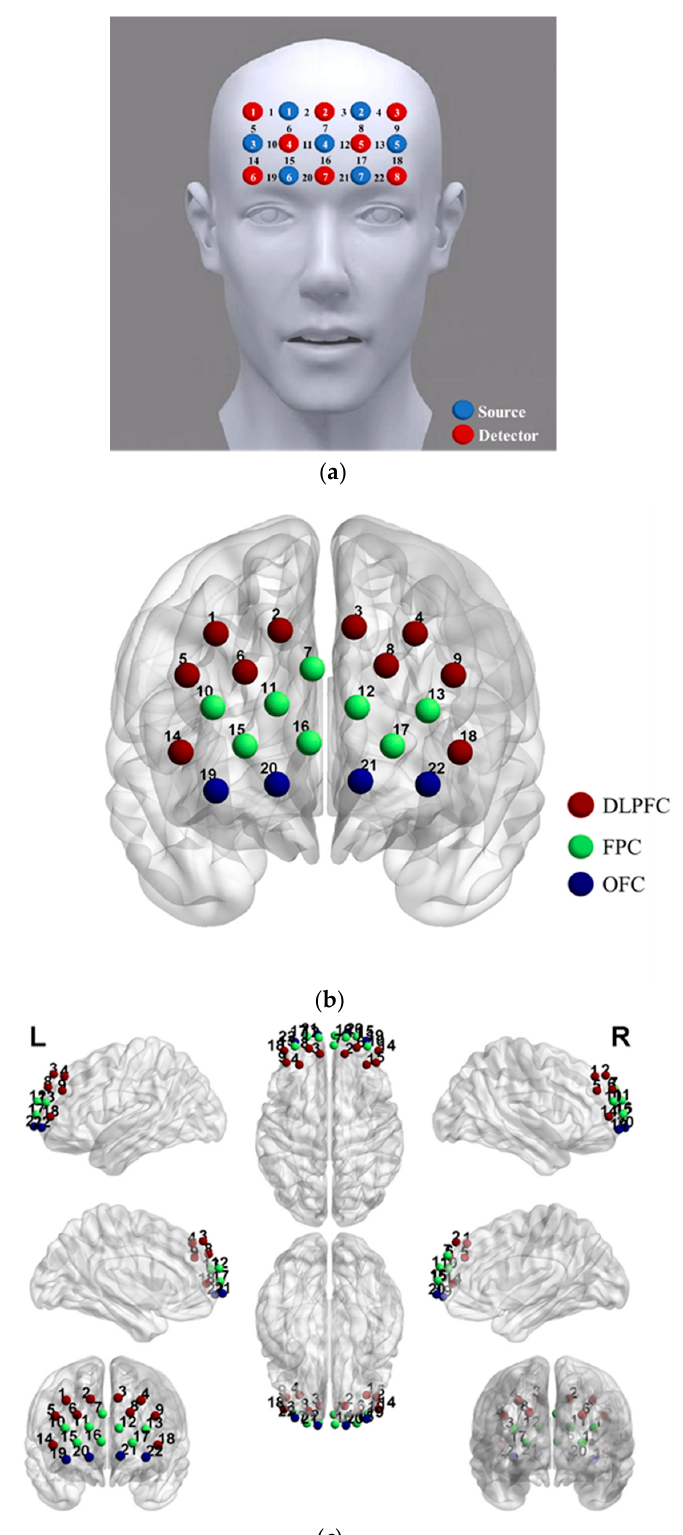
Figure 1. ( a ) Positions of fifteen optodes (eight sources and seven detectors) and fNIRS channels. ( b ) Fifteen optodes were attached to the prefrontal cortex forming 22 channels in frontal view. ( c ) The 3D MNI coordinates of 22 channels in a different view. DLPFC means dorsolateral prefrontal cortex, FPC means frontopolar cortex, OFC means orbitofrontal cortex.